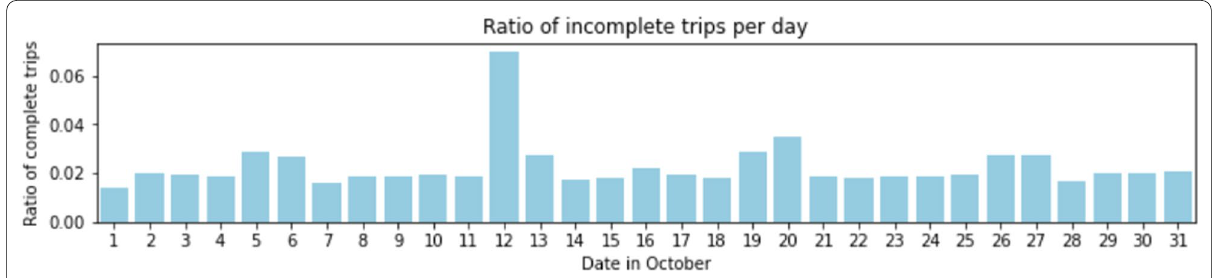
Fig. 6 Ratio of incomplete trips over all trips per day in the Lisbon Metro